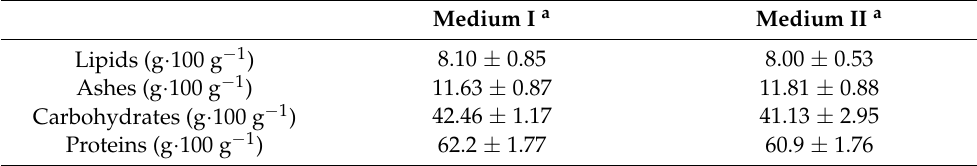
Table 2. Biomass